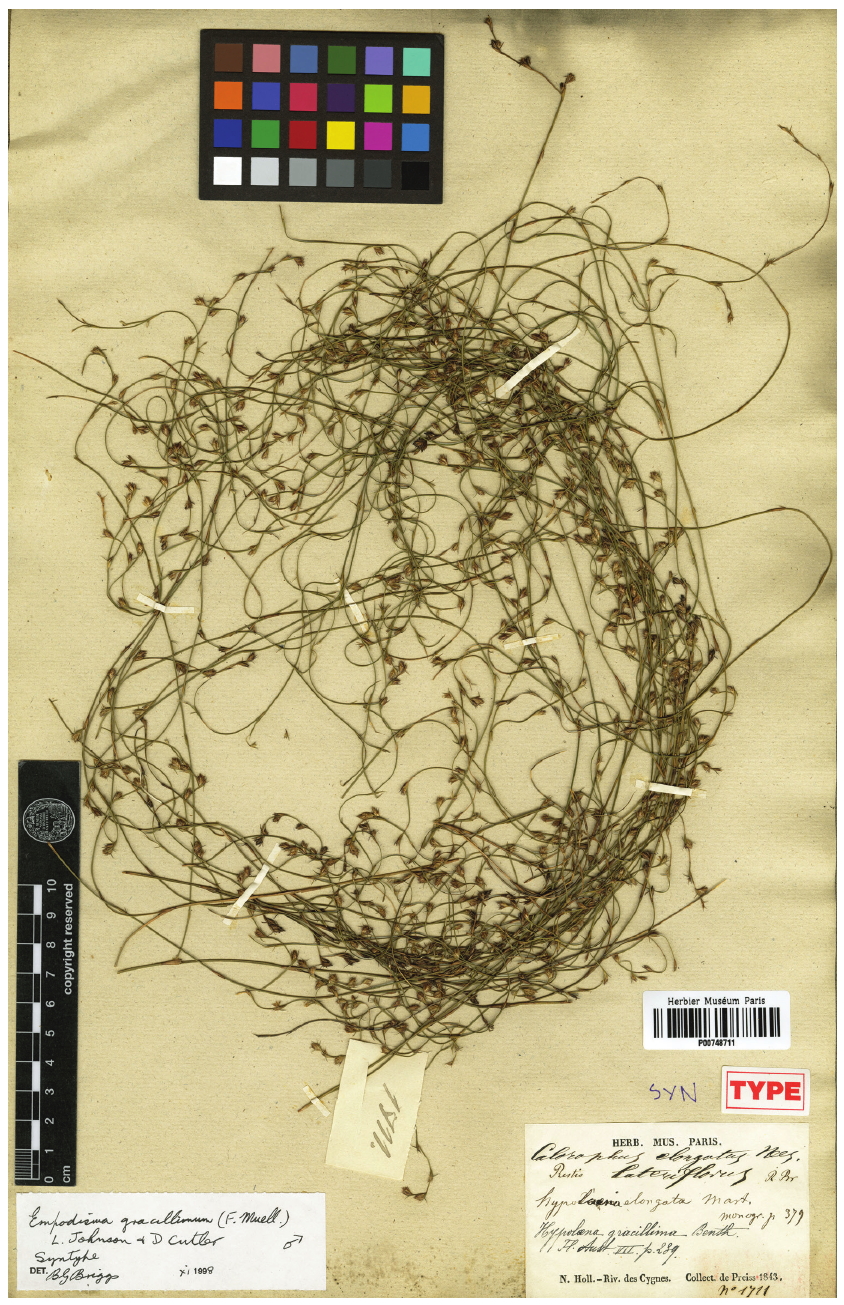
Figure 12. High resolution photograph of a syntype of Empodisma gracillimum (F.Muell.) L.A.S. John- son & D.F.Cutler. Mueller (1872–74) originally described the plant as Calorophus gracillimus F.Muell. The specimen, Nouvelle-Hollande, Riv. des cygnes, Preiss JA 1711, 1843, P00748711 is held at HER- BARIUM MUSEI PARISIENSIS. The syntype was designated by BG Briggs